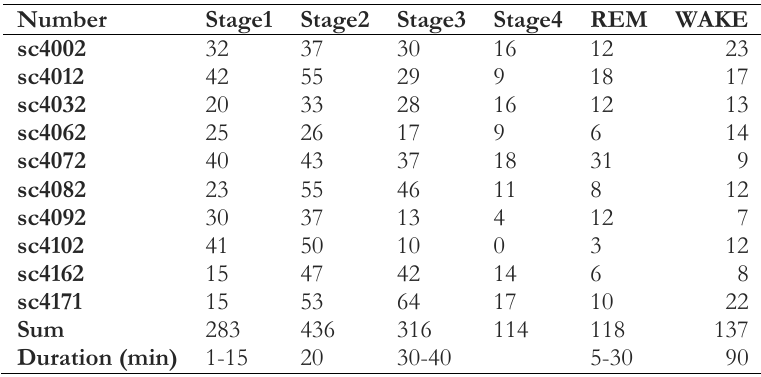
Fig. 5. Representing EEG signals at different stages of sleep. Table 1. The number of sleep stages that occurred for the studied